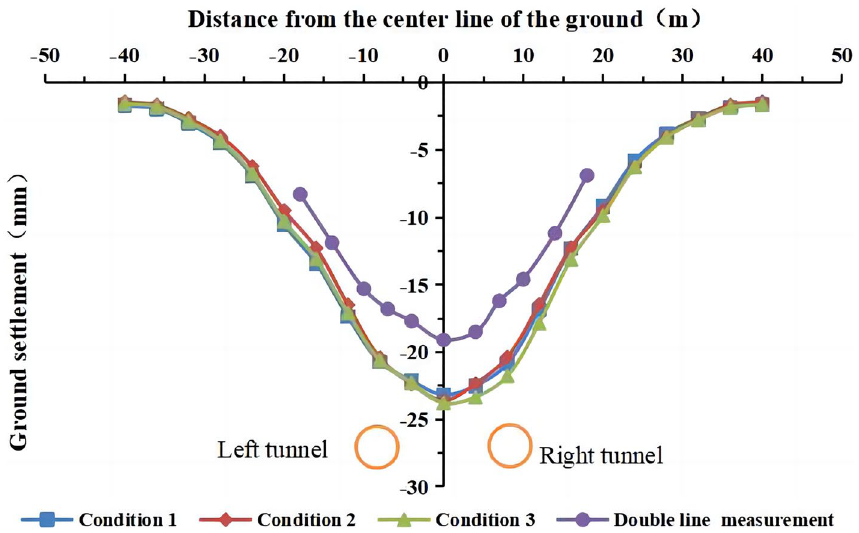
Figure 15. Comparison of the simulated and measured surface settlement for the three working